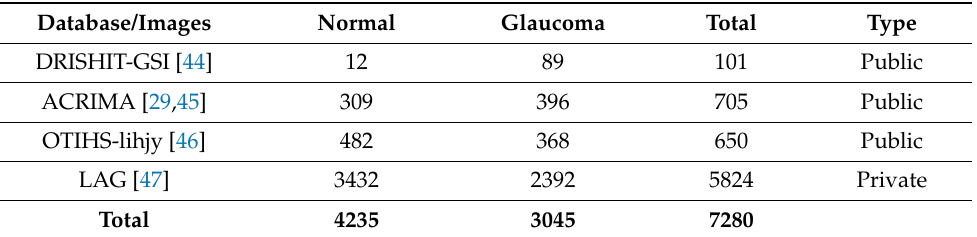
Table 2. Dataset